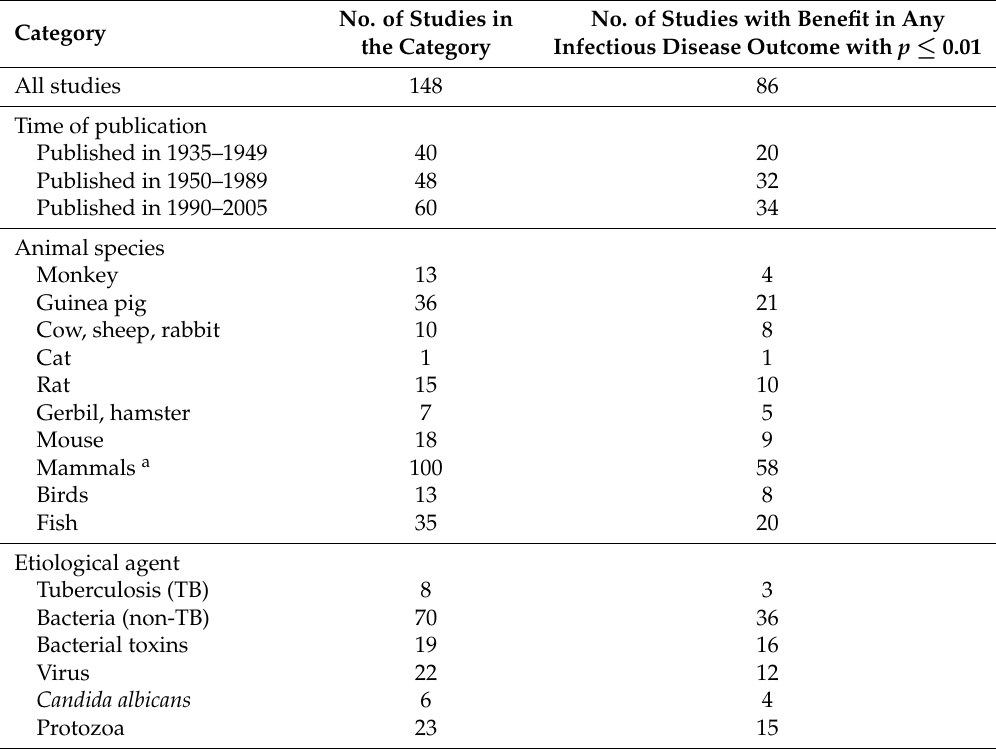
Table 2. Effect of pure vitamin C on infectious disease outcomes in animal studies.